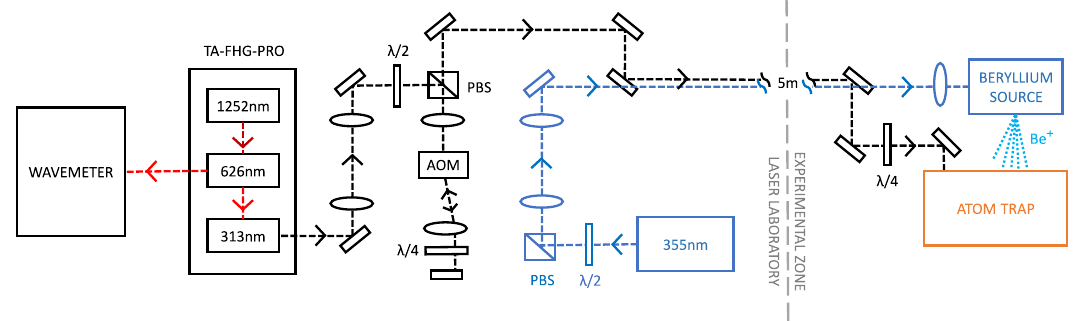
Fig. 9 Laser-setup for ablation (blue) and laser-cooling (black). The TA-FHG PRO from Toptica generates 313 nm by two doubling stages of a 1252 nm ampli fi ed diode laser. The second harmonic light at 626 nm is sent to a wavemeter for frequency control (see below). The double-pass AOM setup is used to sweep the laser for fl uorescence-based detection (the detection geometry was indicated in Fig. 1). The polarization beam splitters (PBS) for both lasers serve, through changes of polarization to control the power delivered to the experiment. Both lasers are passed through a periscope setup from the laser room to the experiment. The quarter-wave plate on the 313 nm path before it enters the Atom Trap serves to tune the polarization.